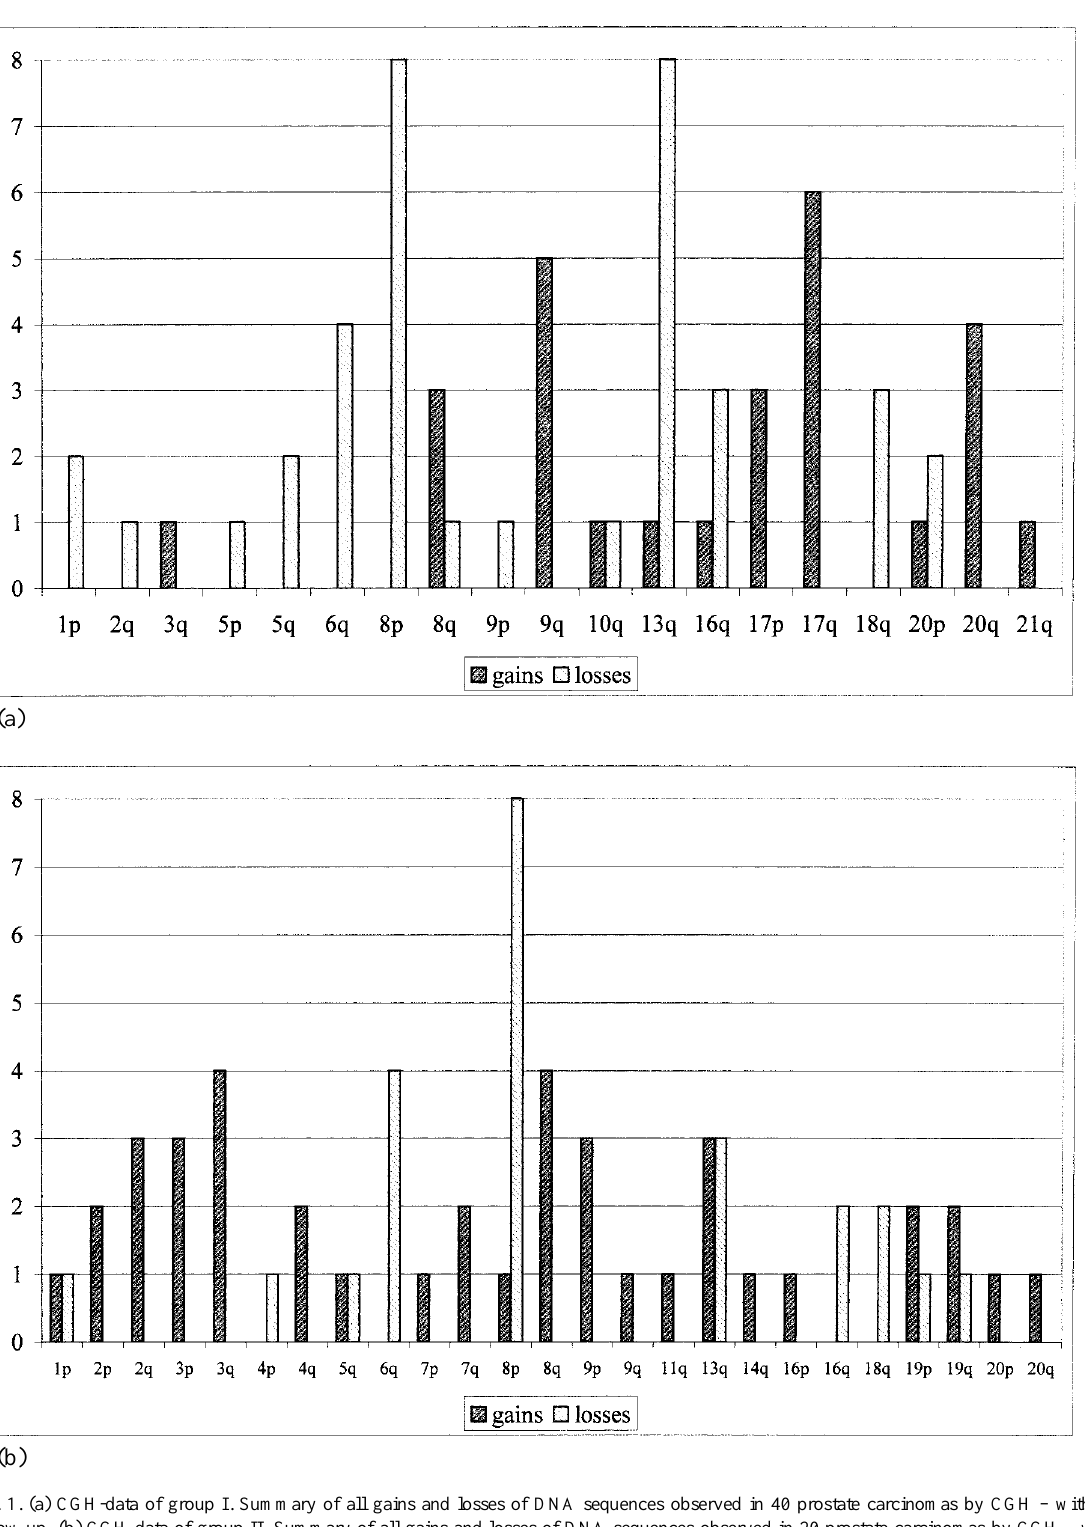
Fig. 1. (a) CGH-data of group I. Summary of all gains and losses of DNA sequences observed in 40 prostate carcinomas by CGH – without follow-up. (b) CGH-data of group II. Summary of all gains and losses of DNA sequences observed in 20 prostate carcinomas by CGH – with